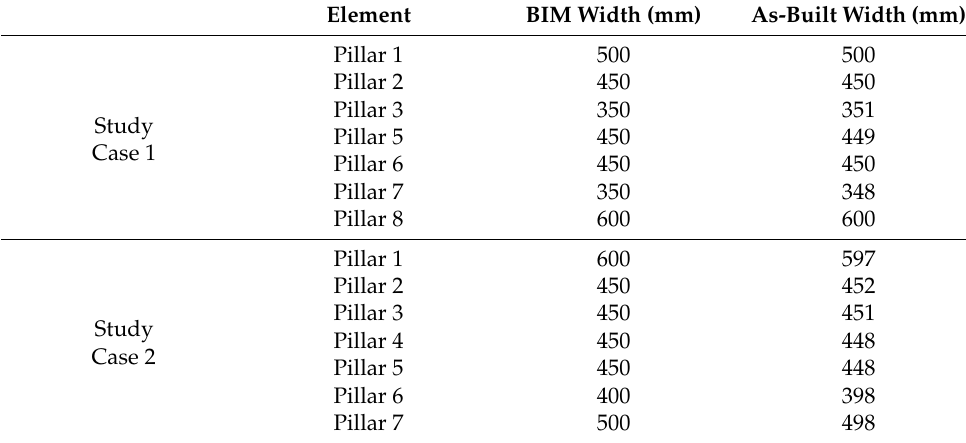
Table 5. Results of the control measurements performed in the different pillars, seven for the first study case and seven for the second study case.